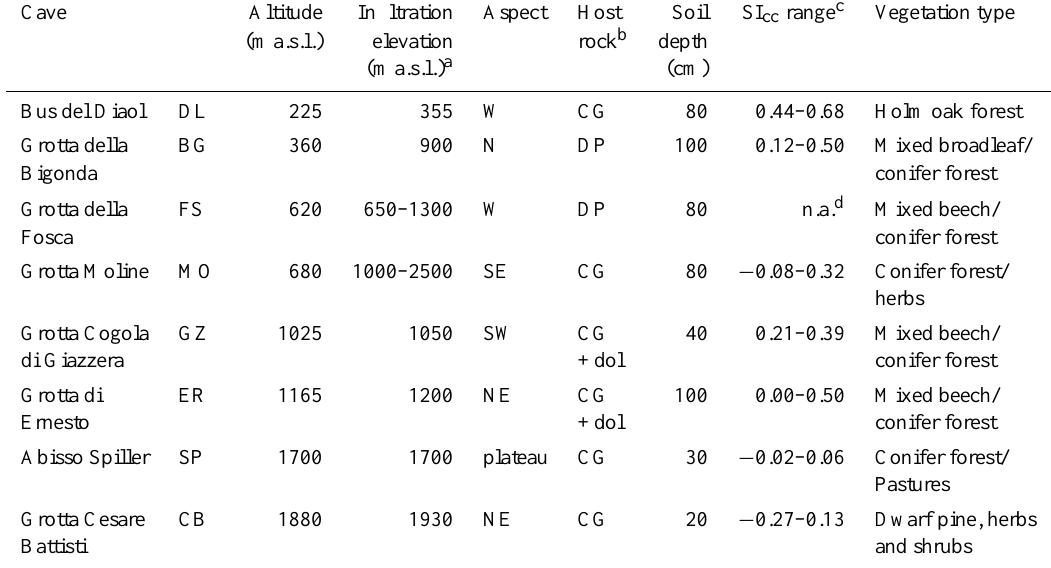
Table 1. Location and characteristics of